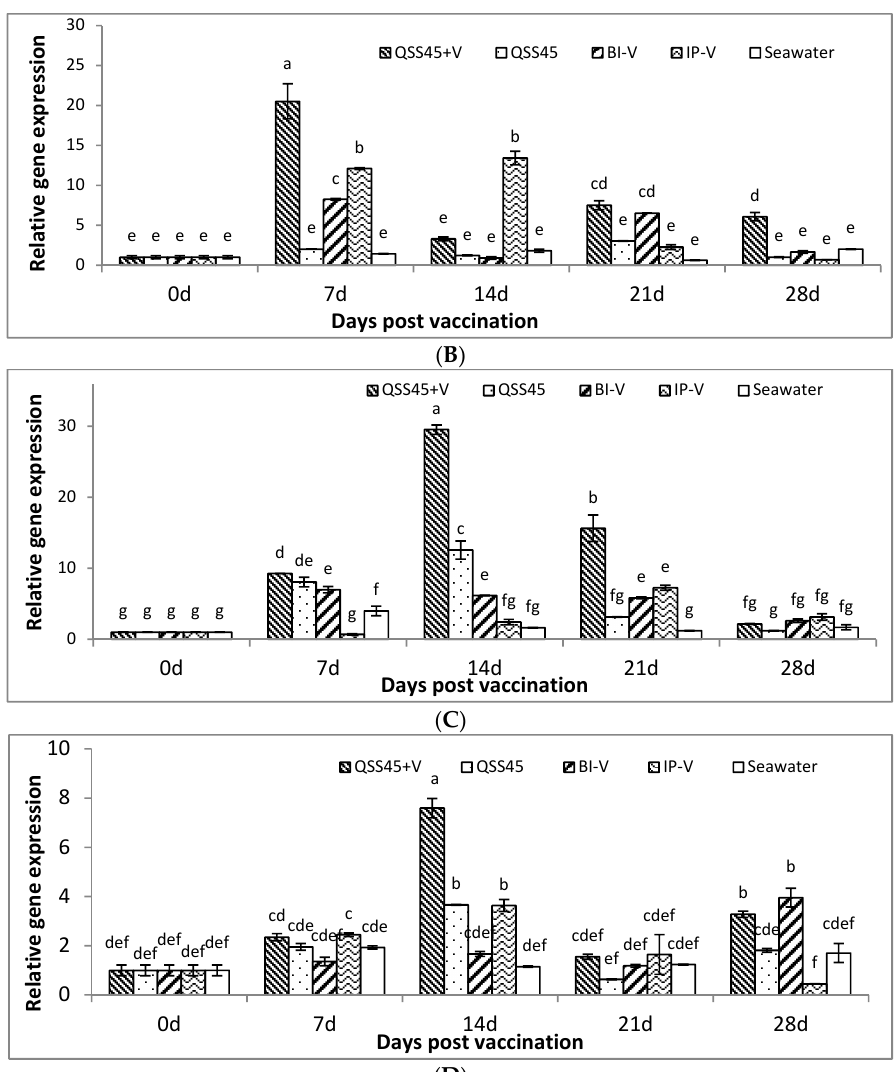
Figure 3. Expression of IgM mRNA in the tissues of skin ( A ); gill ( B ), spleen ( C ) and kidney ( D ) in various treatment groups at days 0, 7, 14, 21 and 28 post-immunization. Different letters indicate significant difference ( p < 0.05) between groups. Data represent as the mean value ± S.E. of three replicates.